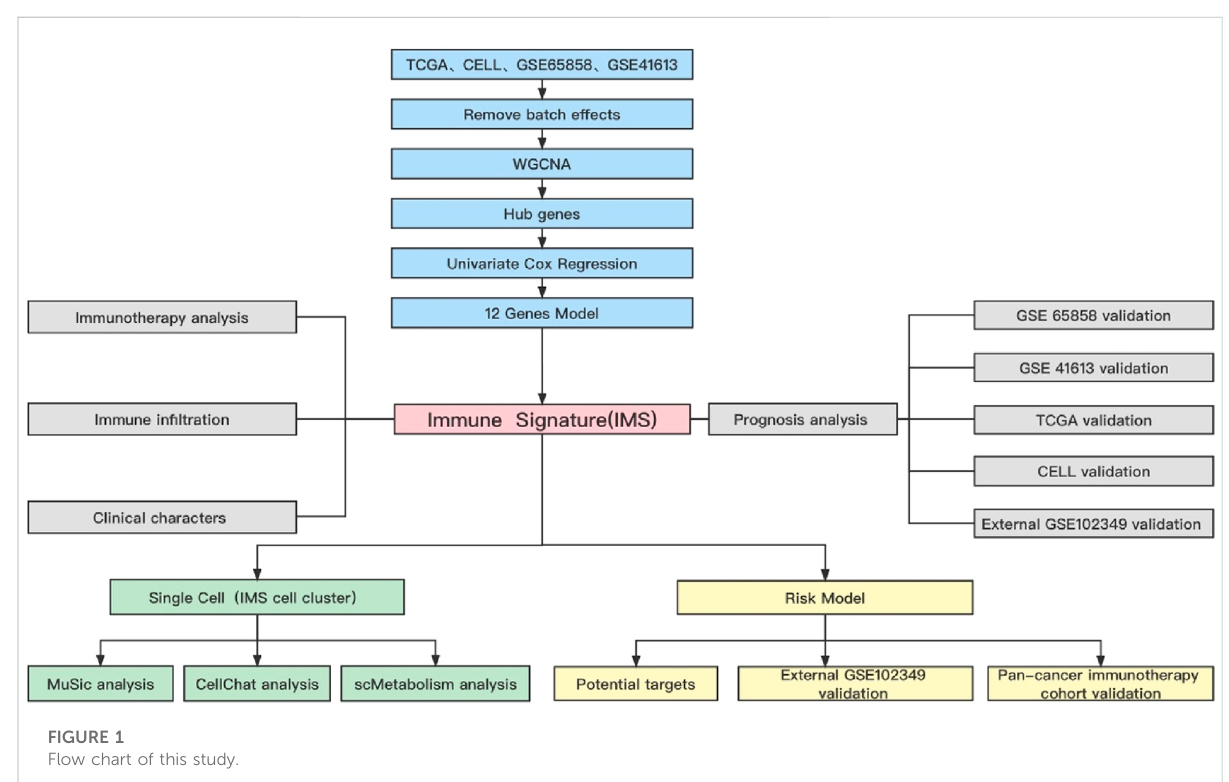
FIGURE 1 Flow chart of this